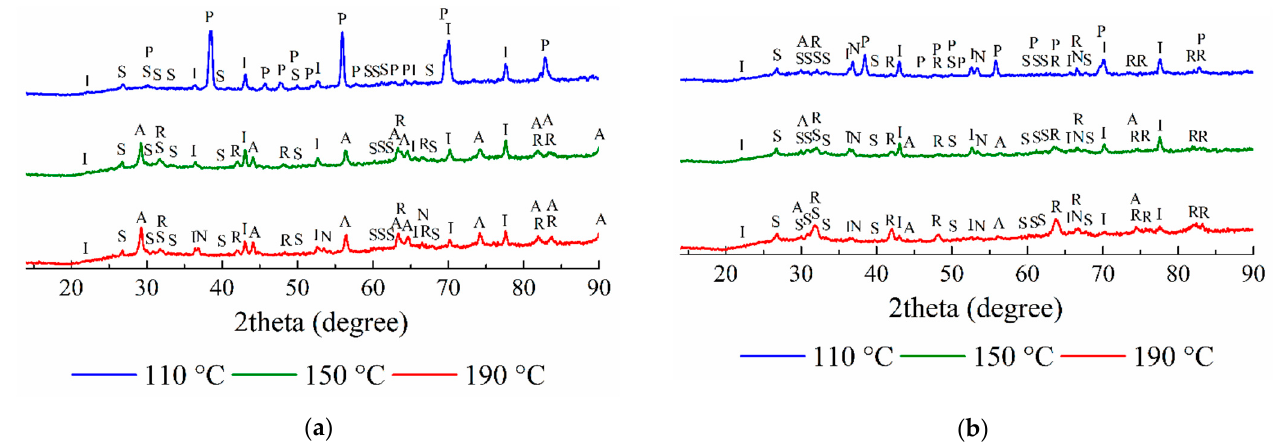
Figure 10. The XRD patterns of the solid residues after the leaching of SSAT sample using 10% ( a ) and 20% HCl ( b ), where P—CaTiO 3 ; A—TiO 2 (anatase); R—TiO 2 (rutile); S—sulfur ( α -S 8 ); D—5Al 2 O 3 ∙ H 2 O; N—NaCl; I—MgAl 2 O 4 .